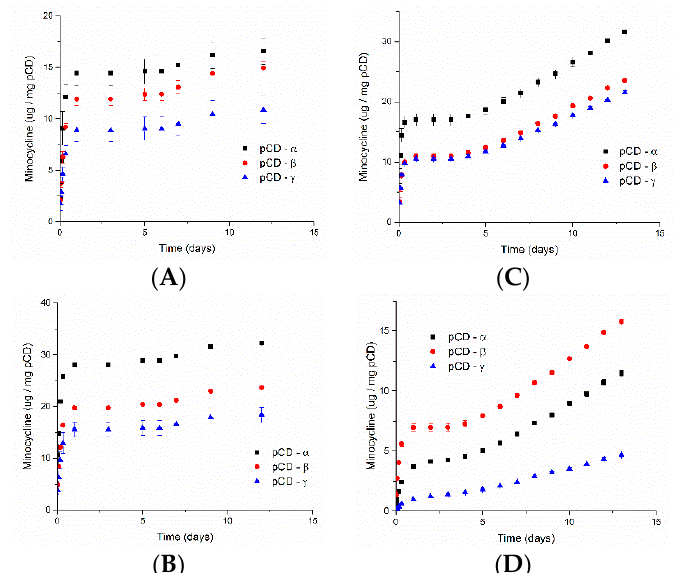
Figure 5. Cumulative minocycline (MNC) release normalized to pCD weight. The trend for release changed with increasing pCD crosslink ratio. At 1:0.08 ( A ) MNC released pCD- α > pCD −β or −γ as crosslinking increased from 1:0.16 ( B ) MNC released from pCD– β approached that from pCD- α by 1:0.32 ( C ) and at 1:0.64 ( D ) pCD– β > pCD- α or – γ . MNC was loaded three days at room temperature prior to releasing into phosphate buffered saline (PBS) at 37 °C. An aliquot was removed at each time point and replaced with fresh PBS to maintain constant volume. Data shown is average ± std deviation for n = 3.